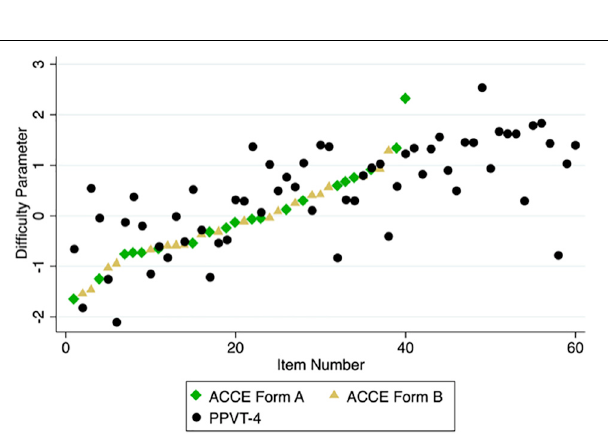
FIGURE 5 | Item Characteristic Curves for Form A and Form B of the ACCE-V. Plot created with Shiny Item Analysis.